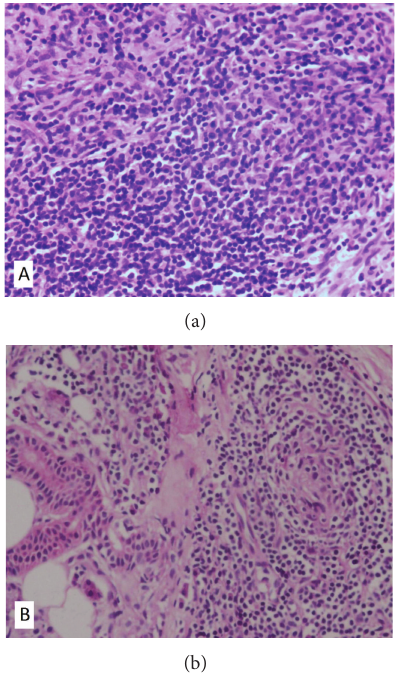
F 2: Histological pictures of Case 1. (a) Specimen obtained from the temporal bone demonstrates �broblasts proliferation in an in�ammatoryin�ltrationbackgroundwithpredominanceofplasma cells (H��; original magni�cation 200); (b) specimen of the parotid gland shows proliferation of lymphocytes, and plasma cells. A granuloma-like structure composed of �broblasts, lymphocytes, × and plasma cells was seen (H��; original magni�cation ×